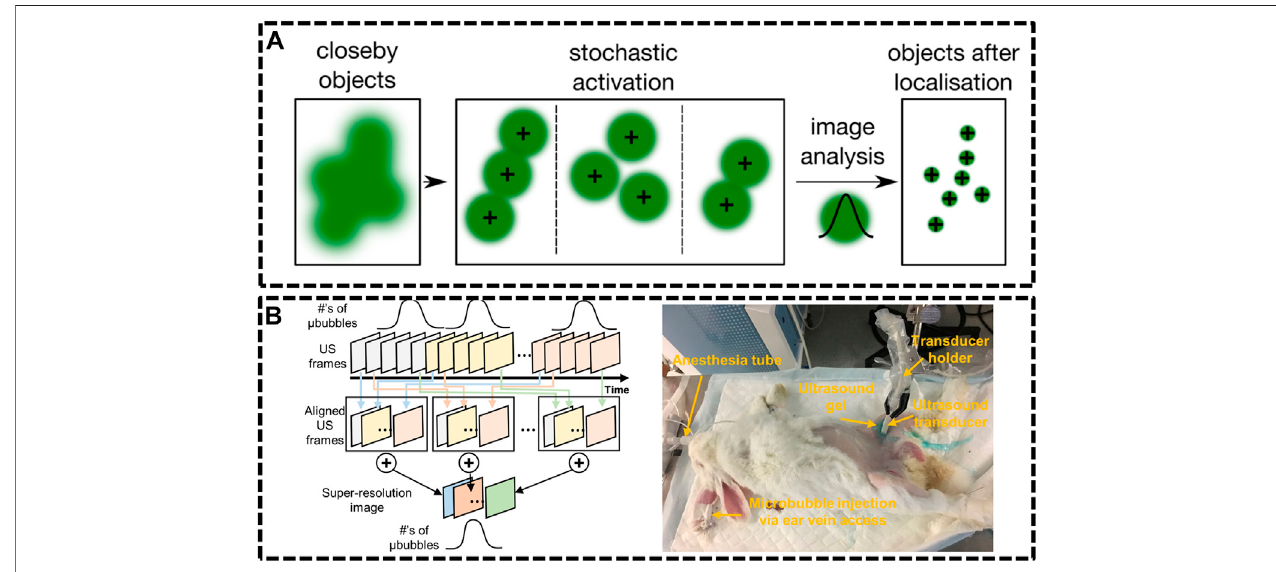
FIGURE 5 | Ultrasound localization microscopy (ULM) systems. (A) Principle of single molecule localization microscopies (SMLMs) (Sezgin, 2017). Reprinted from Sezgin (2017) with permission from IOP Publishing. (B) Graphical diagram of super-resolution ultrasound data acquisition and experiment setup of rabbit imaging (Yu et al., 2018). Reprinted from Yu et al. (2018) with permission from Springer